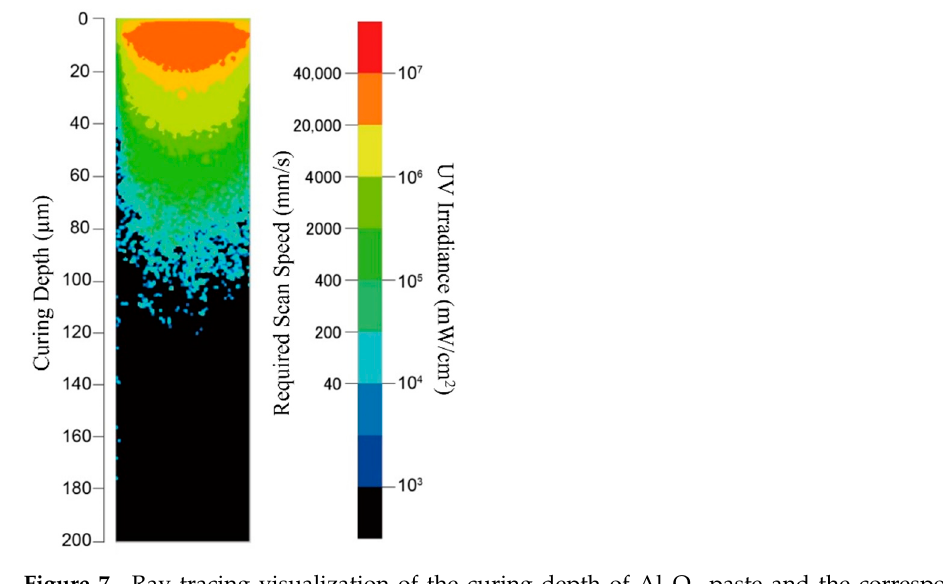
Figure 7. Ray tracing visualization of the curing depth of Al 2 O 3 paste and the corresponding pre- dicted values for required scan